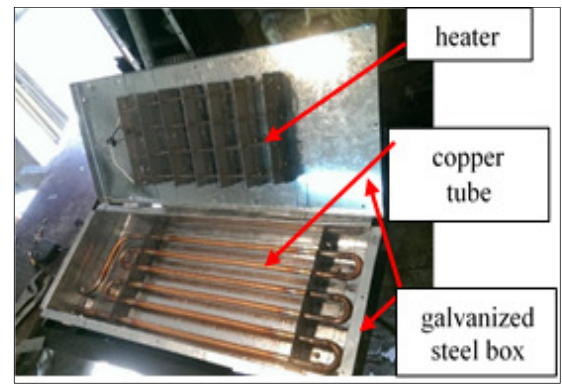
Fig. 4. Details of the electrical heater.